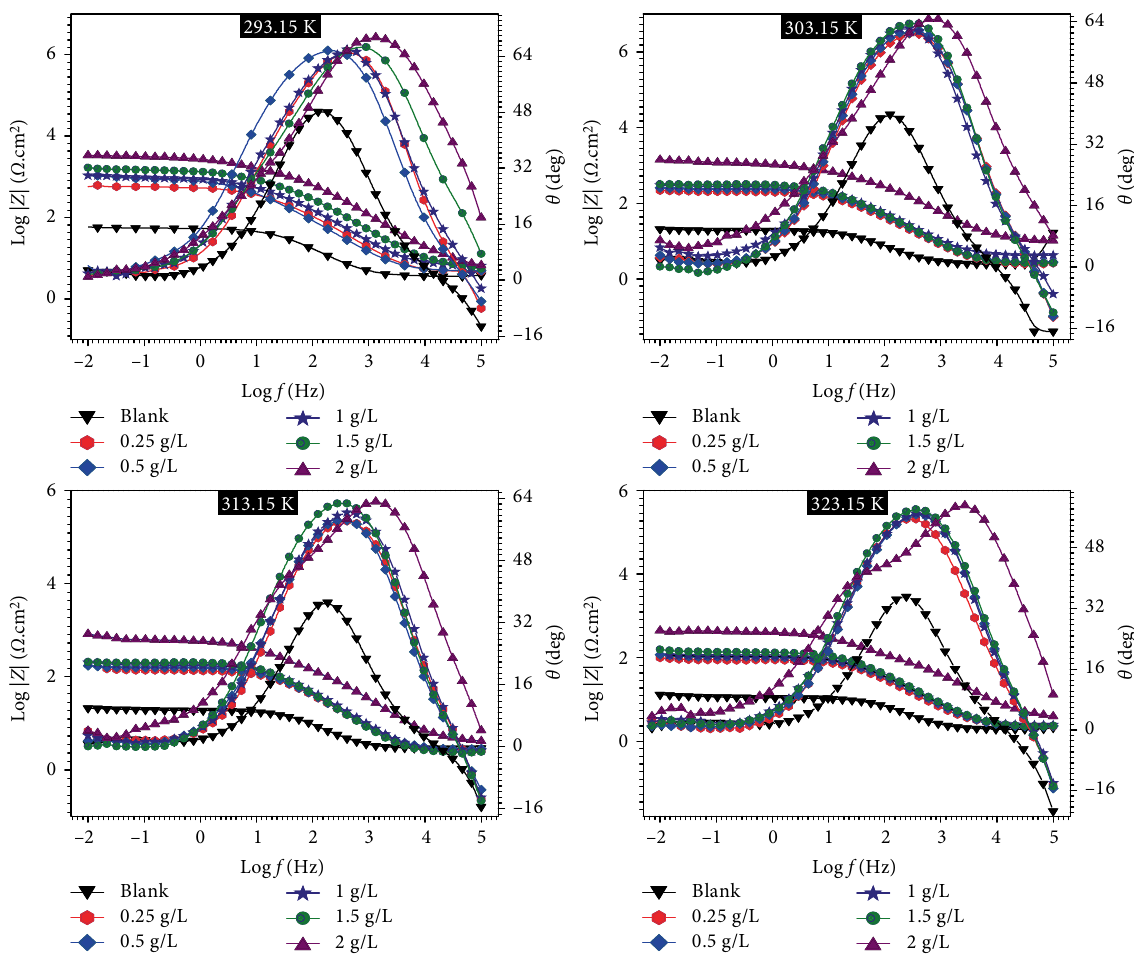
Figure 4: Bode graphs of the measured